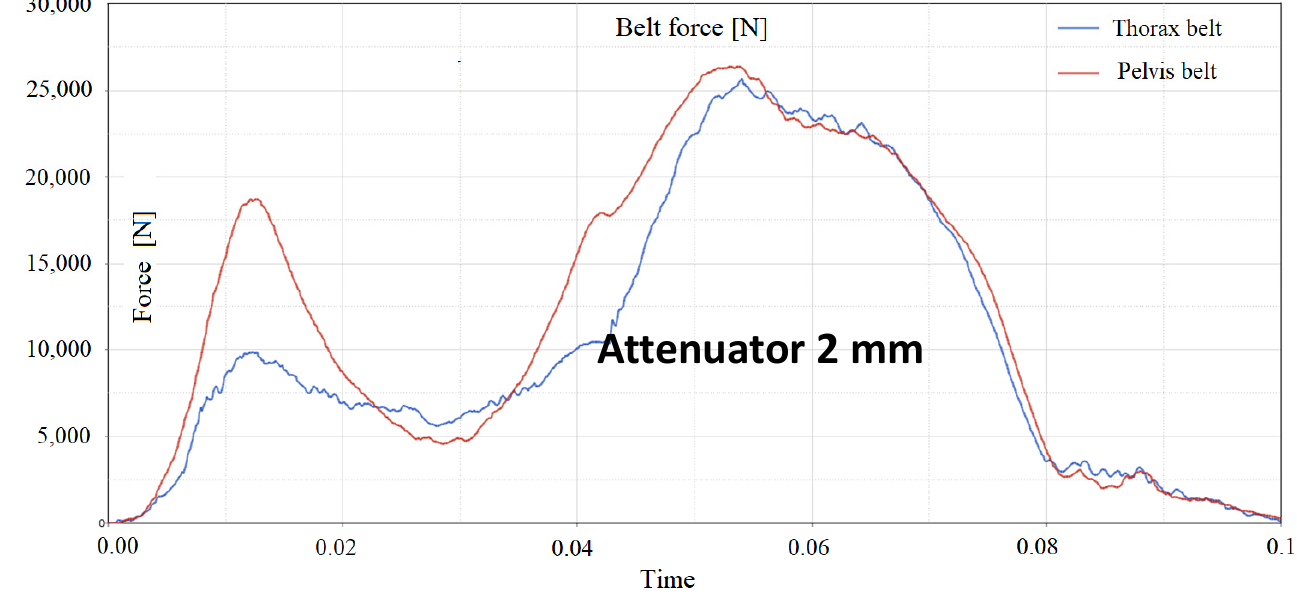
Figure 7. Position after: ( a ) T = 0.025 s; ( b ) T = 0.050 s; ( c ) T = 0.075 s; ( d ) T = 0.10 s. The dimensions are in mm.